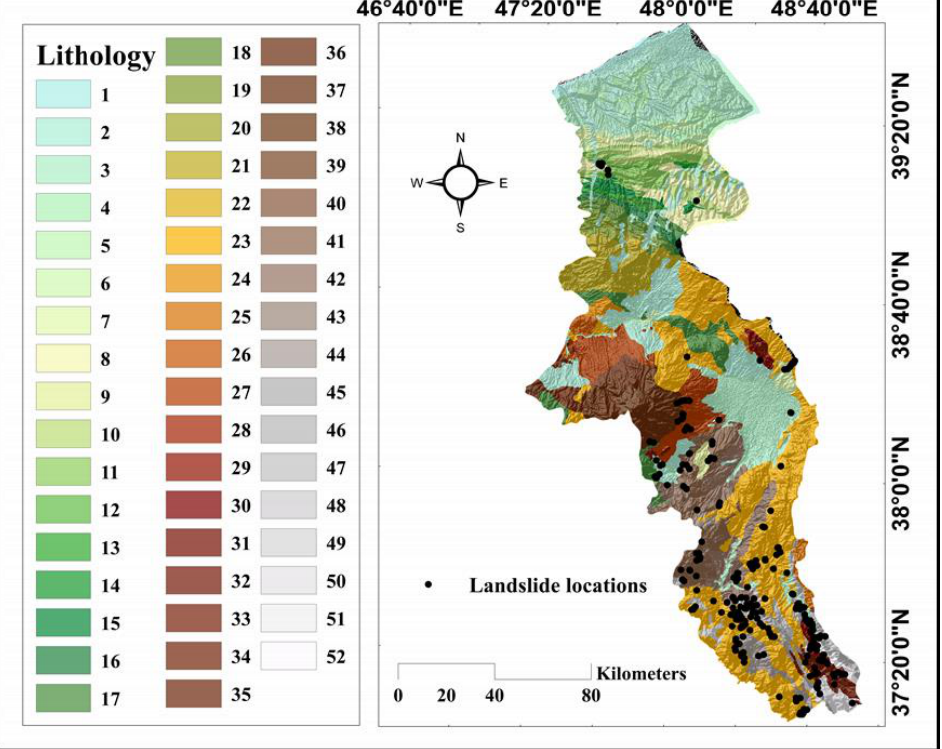
Figure 4. The lithology map of the study area. Table 1. Description of the lithological units.